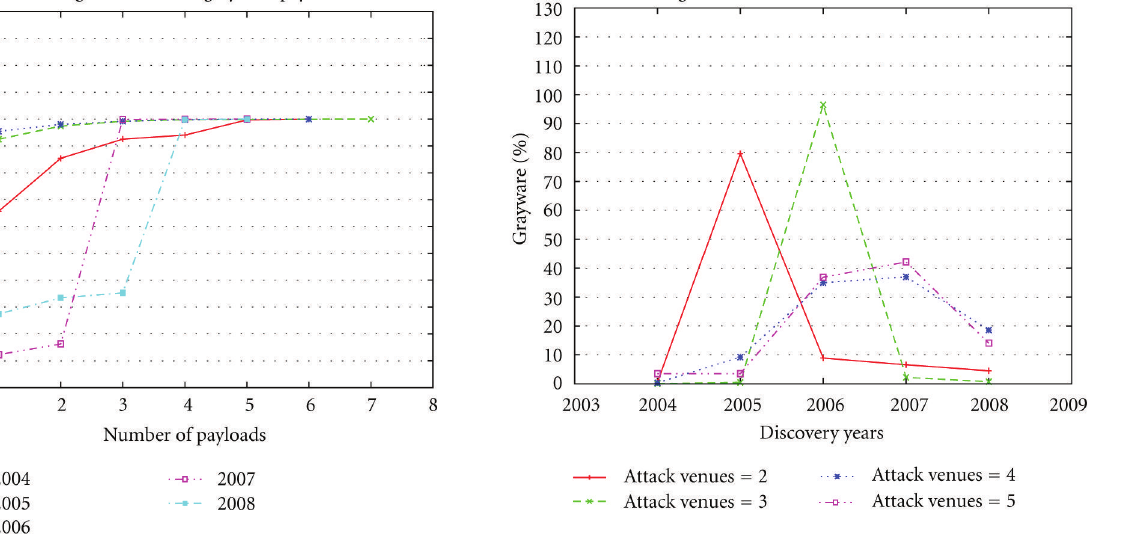
Figure 25: Number of installation venues employed by